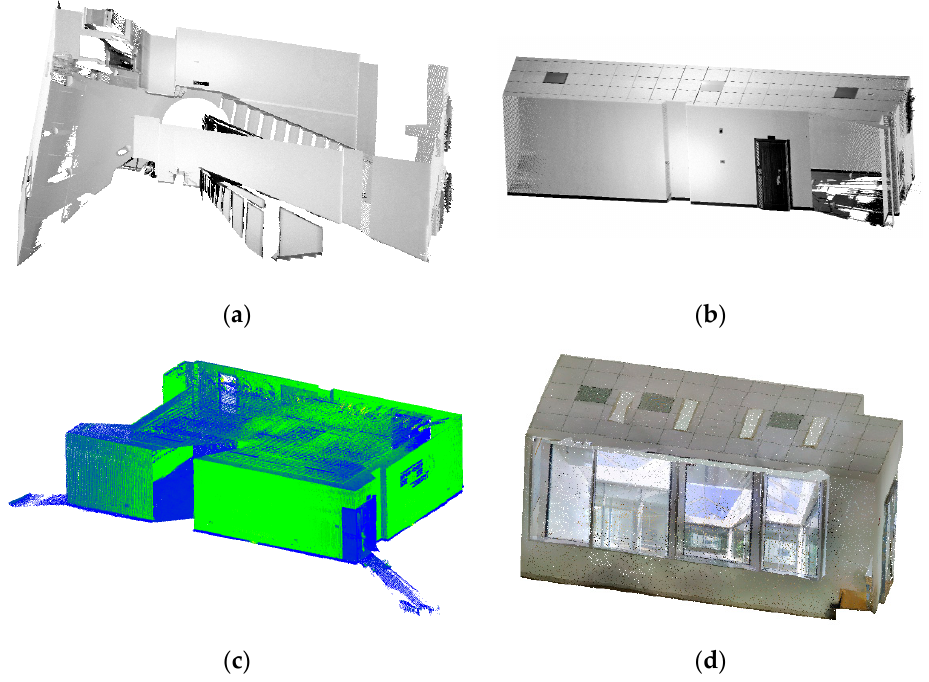
Figure 12. Raw point cloud data. ( a ) Staircase. ( b ) Corridor. ( c ) Laboratory. ( d ) Lounge.